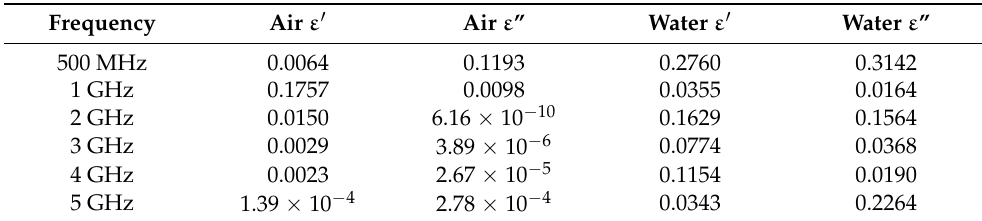
Table 2. Percentage variance in the complex permittivity measurement of reference materials at different